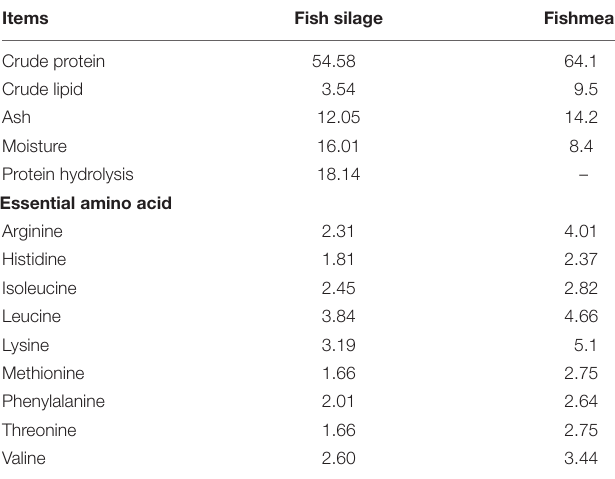
TABLE 1 | Composition of the fish silage powder (g/100 g dry